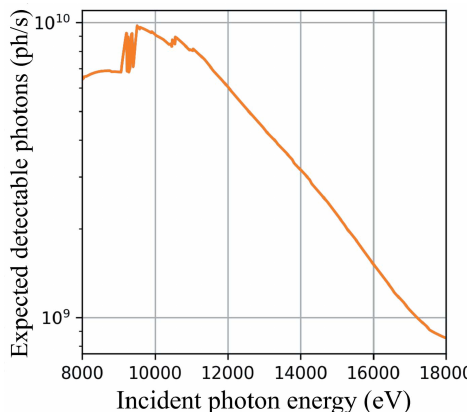
Figure 2 Expected detectable photons with in-line holography at NanoMAX as a function of the X-ray photon energy.